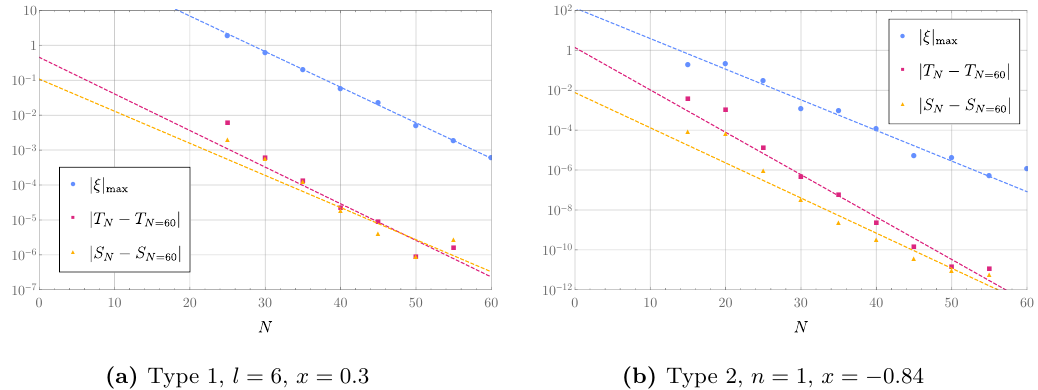
Figure 10 . The vanishing of the DeTurck vector ξ a (blue circles), as well as the convergence of the metric functions T and S (magenta triangles and orange squares) evaluated at the coordinate origin, with increasing numerical resolution. Figure (a) shows the Type 1 deformation (2.5) with l = 6 and x = 0 . 3 , while figure (b) shows the Type 2 deformation (2.7) with n = 1 and x = − 0 . 84 . The dashed best-fit lines show the expected exponential